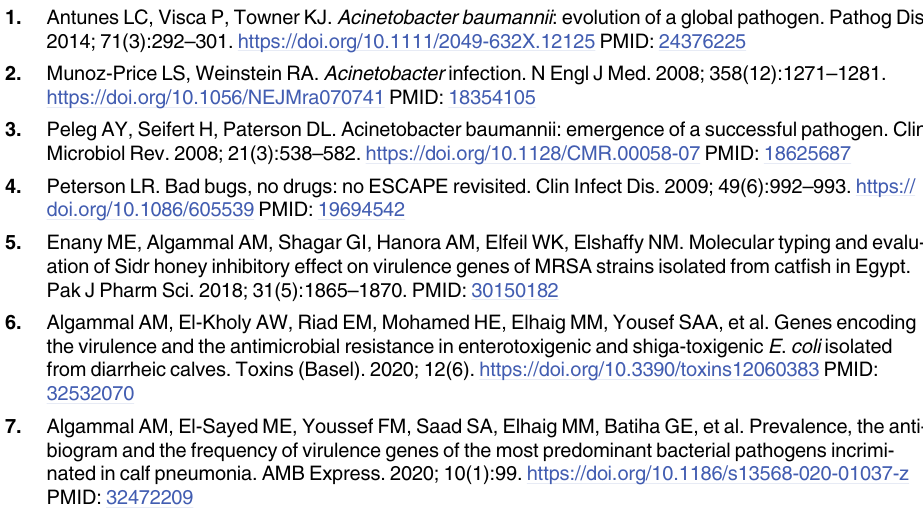
S3 Table. Virulence gene predicted by the VFDB (Virulence Factors of Pathogenic Bacte- ria). S4 Table. The distribution of antibiotic resistance genes in the genome of